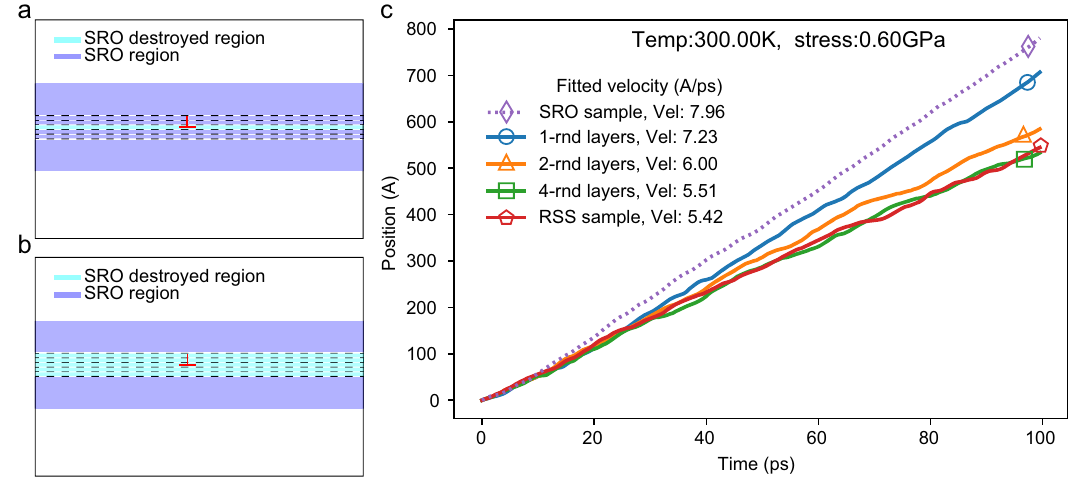
Fig. 6 Attenuated drag effect for the edge dislocation induced by SRO in layers neighboring the guide plane. a The schematic fi gure illustrates the state of SRO in the sample. The edge dislocation is represented in red, indicating the position of the glide plane, and the dashed lines are the corresponding atomic planes parallel to the guide plane. The cyan color represents that the SRO on the slip plane has been destroyed after the edge dislocation glides across the whole periodic cell. The blue regions re fl ect planes where the SRO remains present. b This panel represents the situation for simulations in which SRO is destroyed not only along the slip plane but in neighboring parallel planes. c The effect of the SRO state around the neighboring slip planes of the edge dislocation motion (distance vs. time). The dashed line represents the average velocity of the edge dislocation in a sample where SRO is destroyed only within the guide plane (corresponding to panel ( a )). The solid lines represent the edge dislocation motion in the samples with a controlled number of destroyed SRO layers, i.e., for different thicknesses of the cyan region in panel ( b ). Also shown are results obtained for the RSS sample where SRO is not present on any planes in the